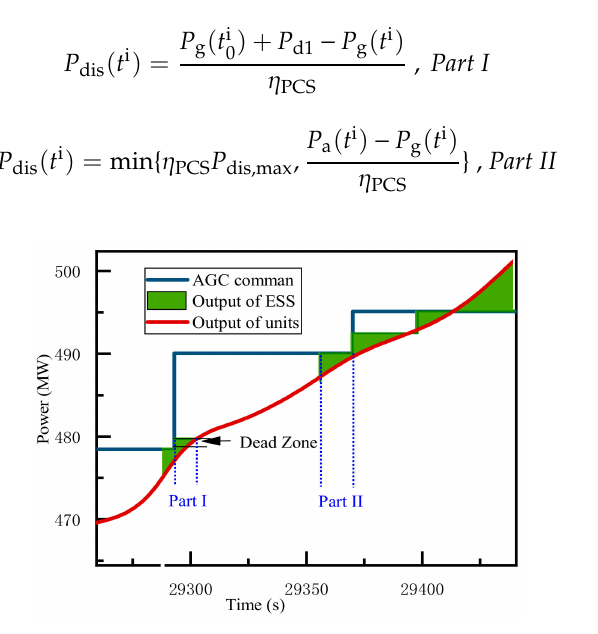
Figure 6. The Negative Strategy of